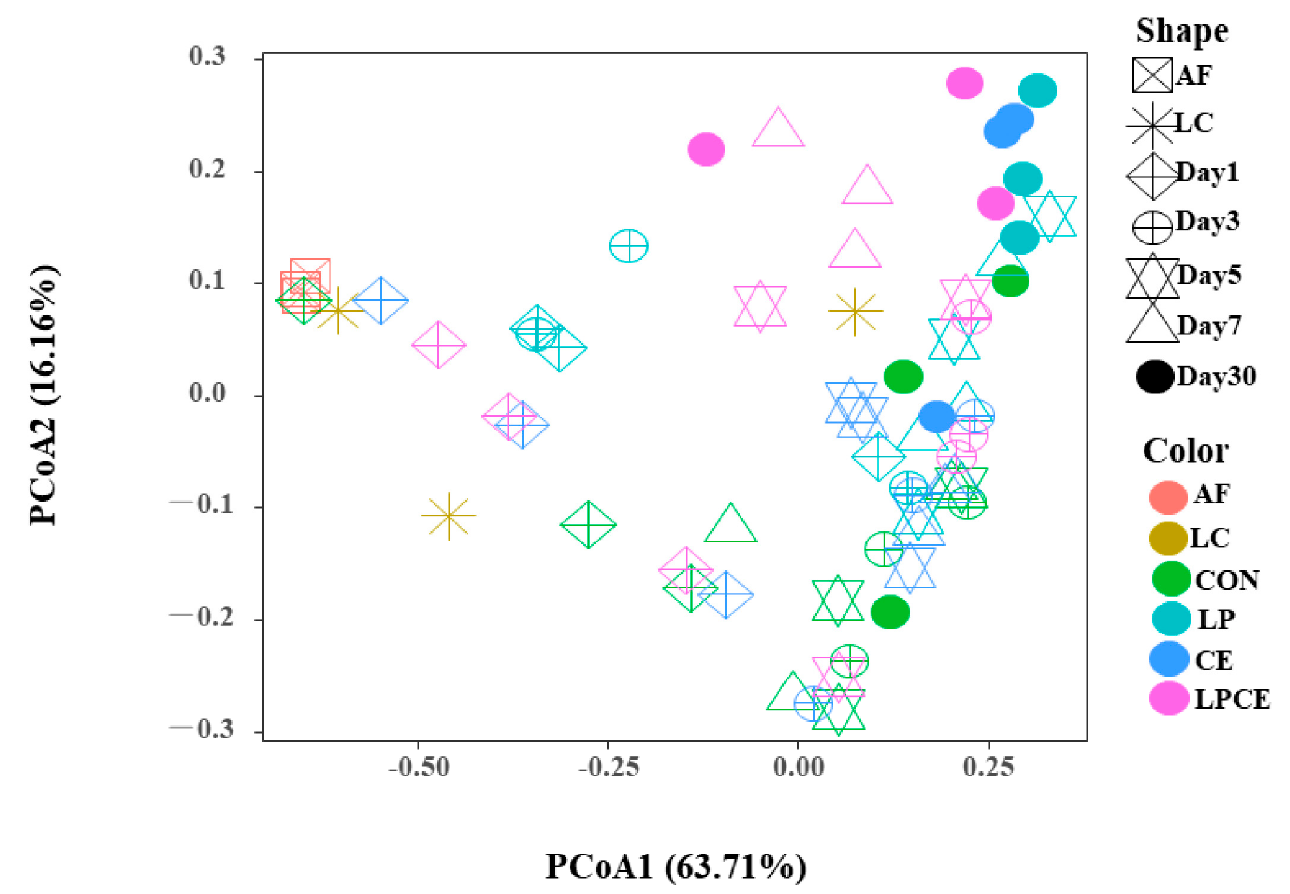
Figure 1. Beta diversity of the bacteria community in the mixed silage during ensiling. (n=3). The principal coordinates analysis (PCoA) of the samples conducted based on weighted UniFrac distance. AF, alfalfa; LC, Leymus chinensis ; CON, control silage, no additive; LP, silage containing Lactiplantibacillus plantarum ; CE, silage containing cellulase; LPCE, silage containing Lactiplantibacillus plantarum + cellulase.